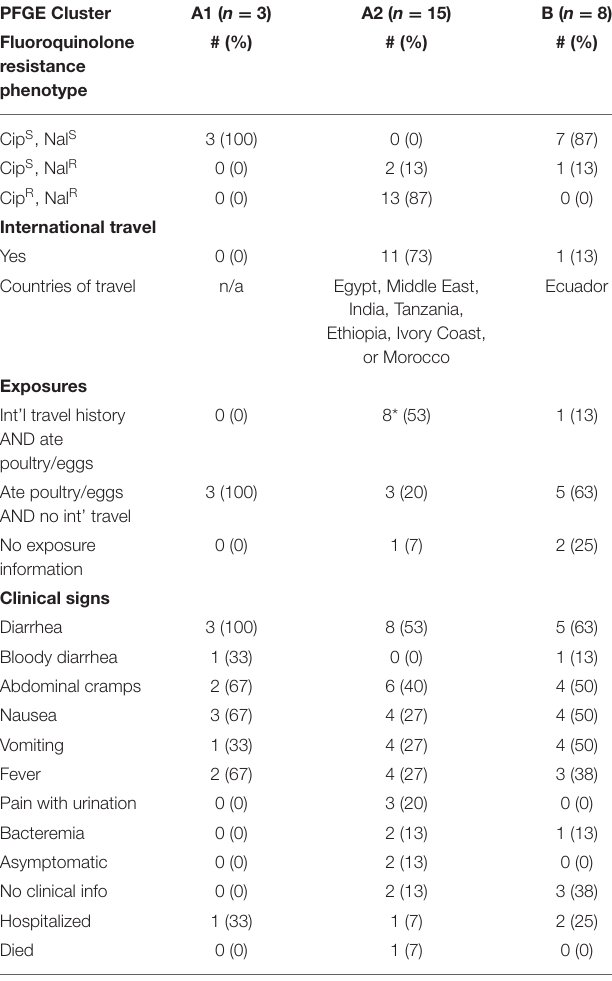
( Supplementary Figure 1 ). Overall, 13/15 isolates (86.7%) within cluster-A2 showed ciprofloxacin resistance and all ( Table 1 ). A whole-genome MLST of representative cluster- A2 isolates (5/15, 33.3%) identified these isolates as ST198 ( Supplementary Figure 1 ). One (6.7%) cluster-A2